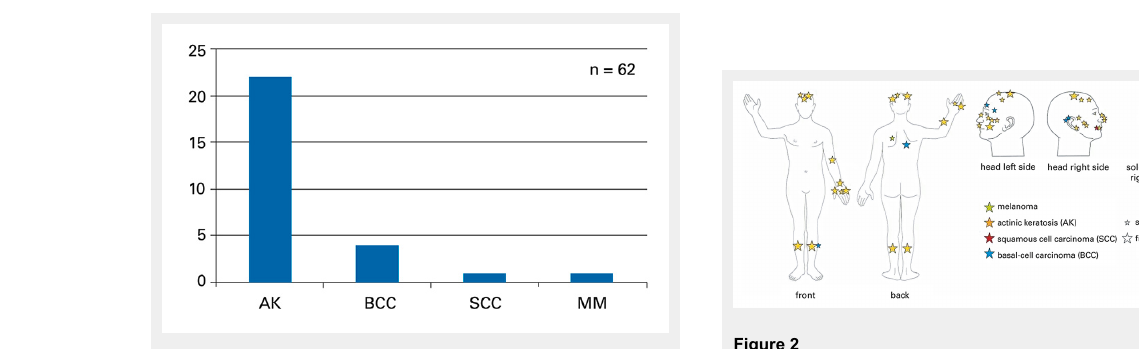
Individuals clinically diagnosed with actinic keratosis (AK), basal- cell carcinoma (BCC), squamous-cell carcinoma (SCC), and with high suspicion for melanoma (MM) during a full body check-up by a dermatologist using a dermatoscope.